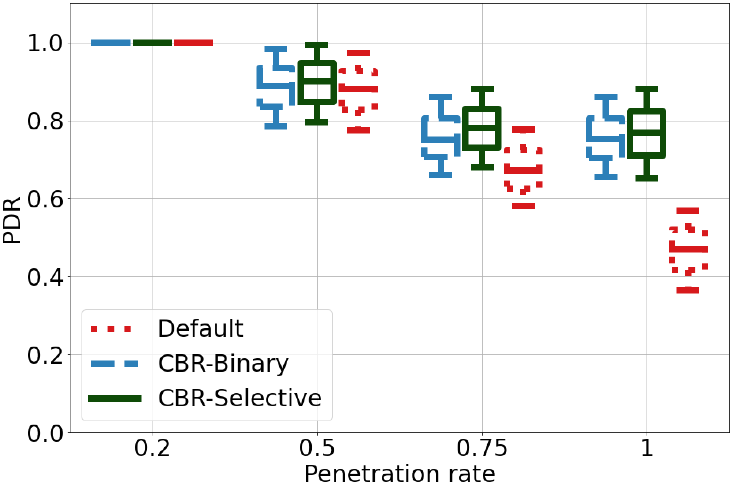
Figure 4. PDR function of penetration rate for CBR-Selective, CBR-Binary and Default